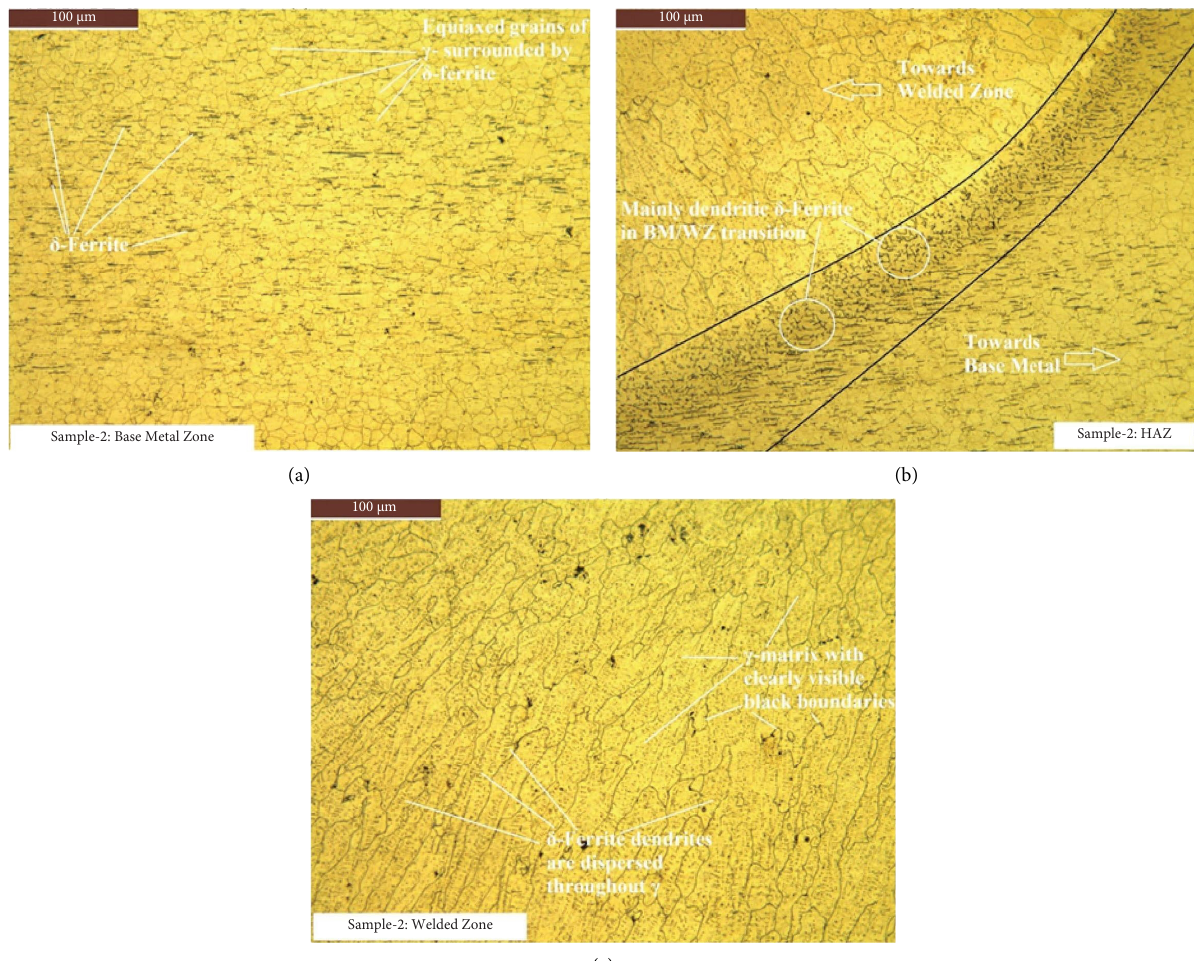
Figure 6: Microstructural appearance of sample 2 (water quenched sample): (a) the base metal, (b) HAZ, and (c) welded